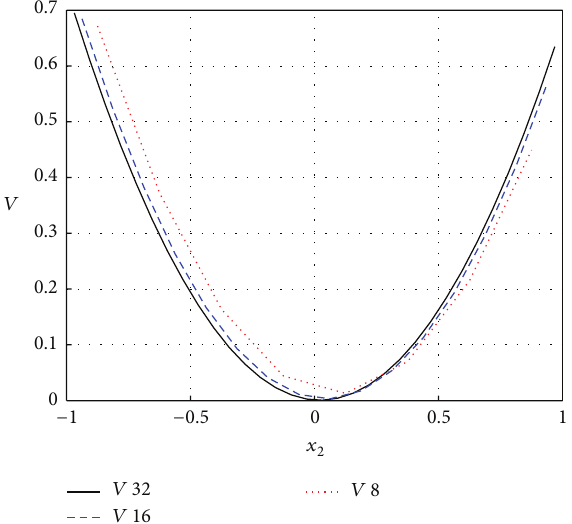
Figure 2: Value cost function for Example 1 via the SHWCM with = −0.1250, −0.0625, −0.0313 , respectively. 𝑚 = 8, 16, 32 and 𝑥 1 where 𝛼 𝑇 1 = [𝛼 11 , . . . , 𝛼 1𝑚 , 0, . . . , 0] and 𝛼 𝑇 2 = [𝛼 21 , 0, . . . , 𝛼 22 , , 0, . . . 0] . 0, . . . , 0, . . . , 𝛼 2𝑚